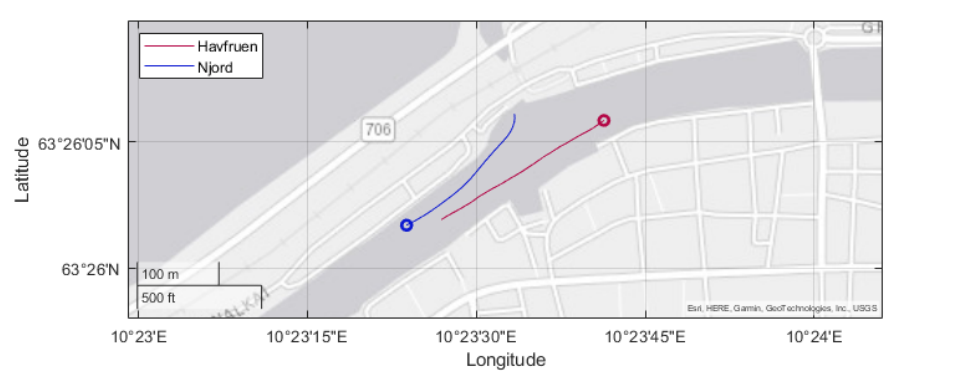
Figure 14. Test case 2. The circle depicts the end position.